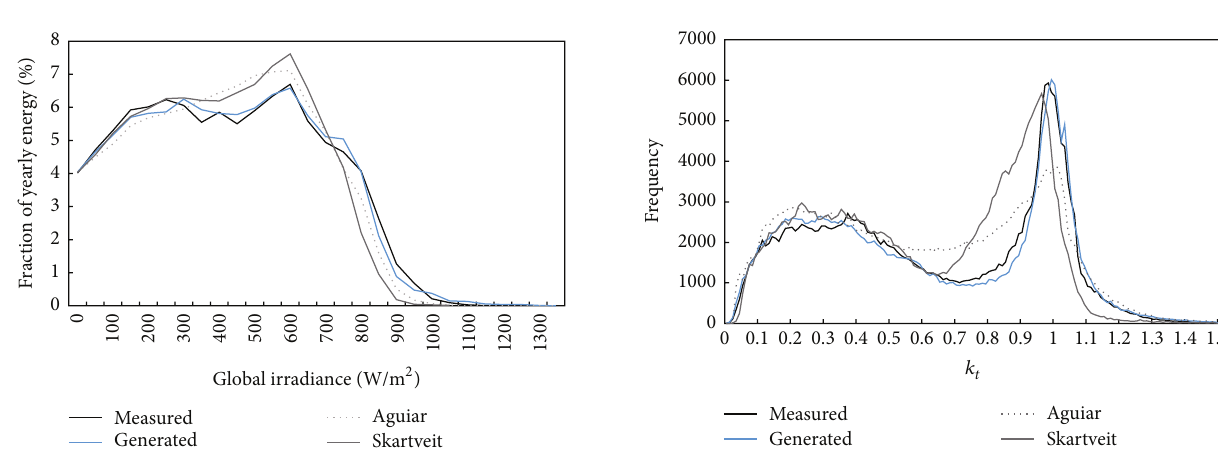
Figure 10: Frequency distributions of the clearness index 𝑘 𝑡 for Lindenberg (Germany, 2005). With the new method, the RMSE between measurement and synthesis can be reduced significantly (RMSE = 596 and 862 counts for Aguiar and Skartveit and RMSE = 207 counts for new method).